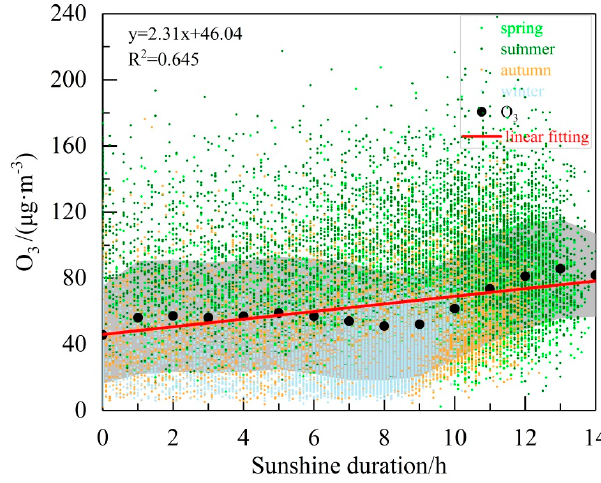
Figure 11. The scatter plot and fitted curve between different sunshine durations and daily mean O 3 mass concentrations. Red line: linear fitting curve of daily average O 3 mass concentration under different sunshine hours; Gray shaded area: standard deviation; Black points: average O 3 under different sunshine hours; Color points: daily average O 3 mass concentration under different sunshine hours of each season.